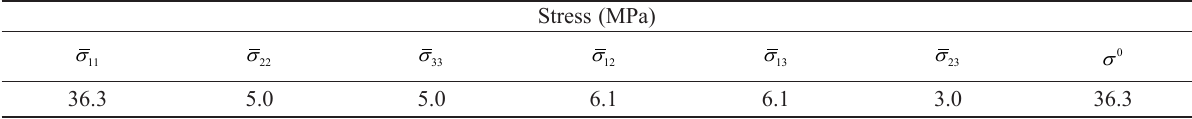
Table 7. Yield points assumed for numerical